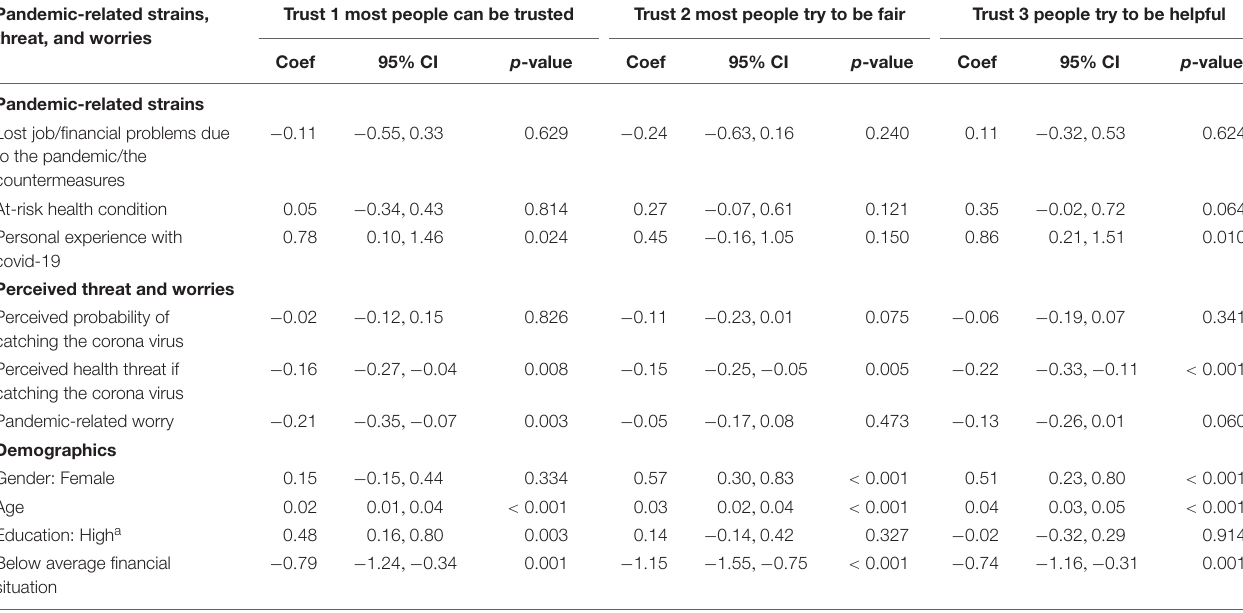
TABLE 3 | Adjusted associations between Demographics, pandemic-related strains, perceived threat and worry, and the three aspects of generalized trust. Pandemic-related strains, Trust 1 most people can be trusted Trust 2 most people try to be fair Trust 3 people try to be threat, and worries